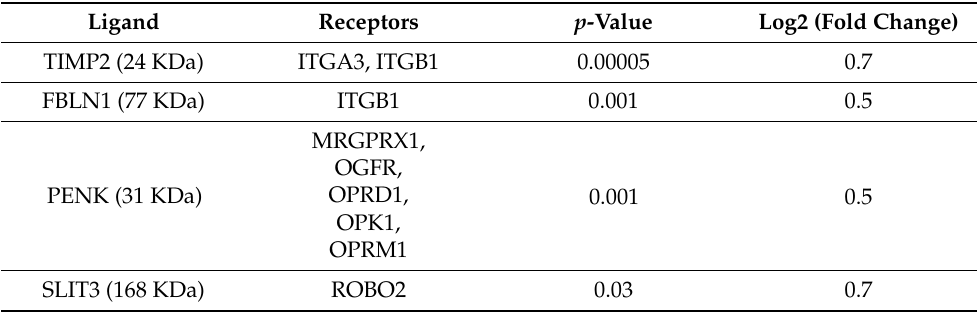
Table 2. Four potential candidate ligands (Figure 7) in the CM of CD36 + FBs are